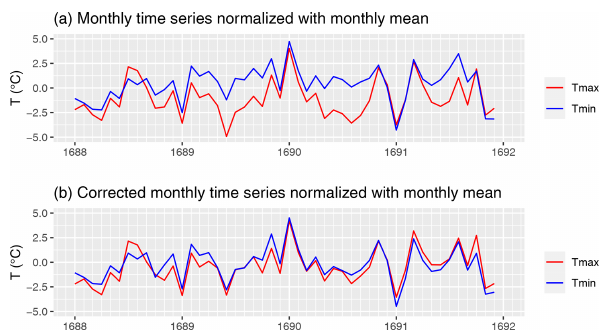
Figure A3. T min and T max normalized with monthly mean values of 1688–1691. In panel (a) are the monthly mean values of Morin’s measurements and in panel (b) the homogenized measurements.